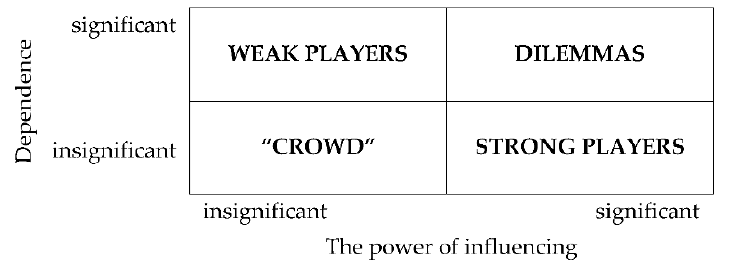
Figure 4. The actor–stakeholder matrix. Source: [13] (p. 262).